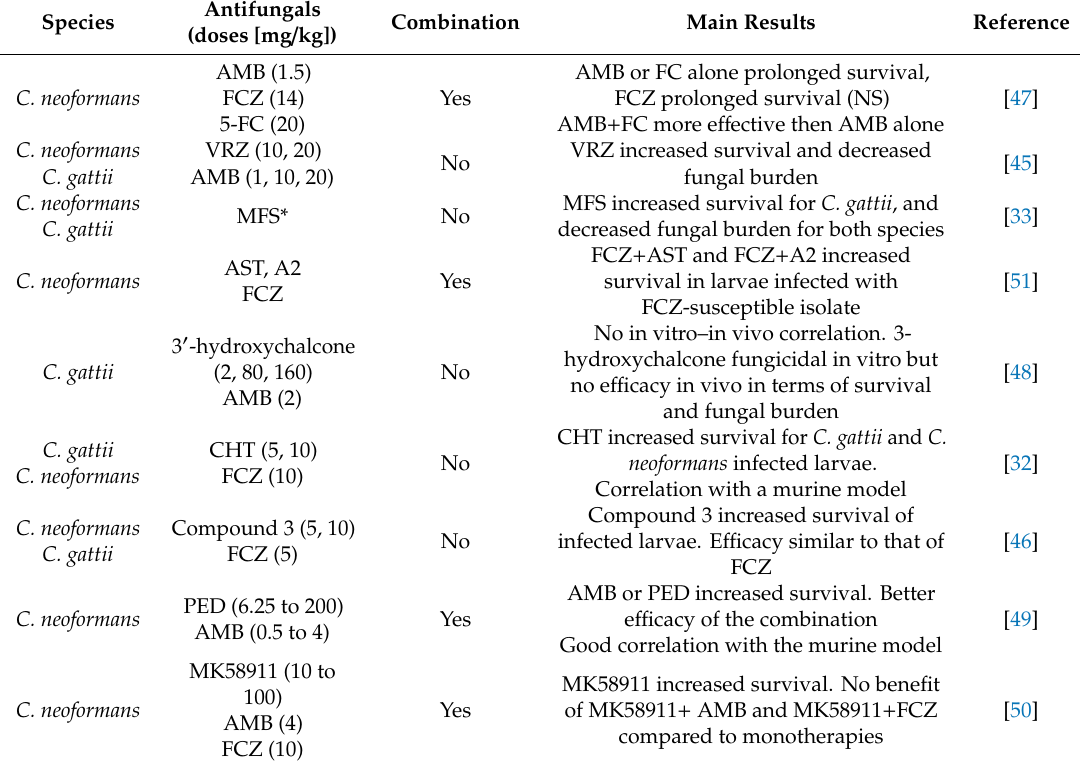
Table 3. Evaluation of antifungal activity for treatment of Cryptococcus infection in Galleria mellonella .